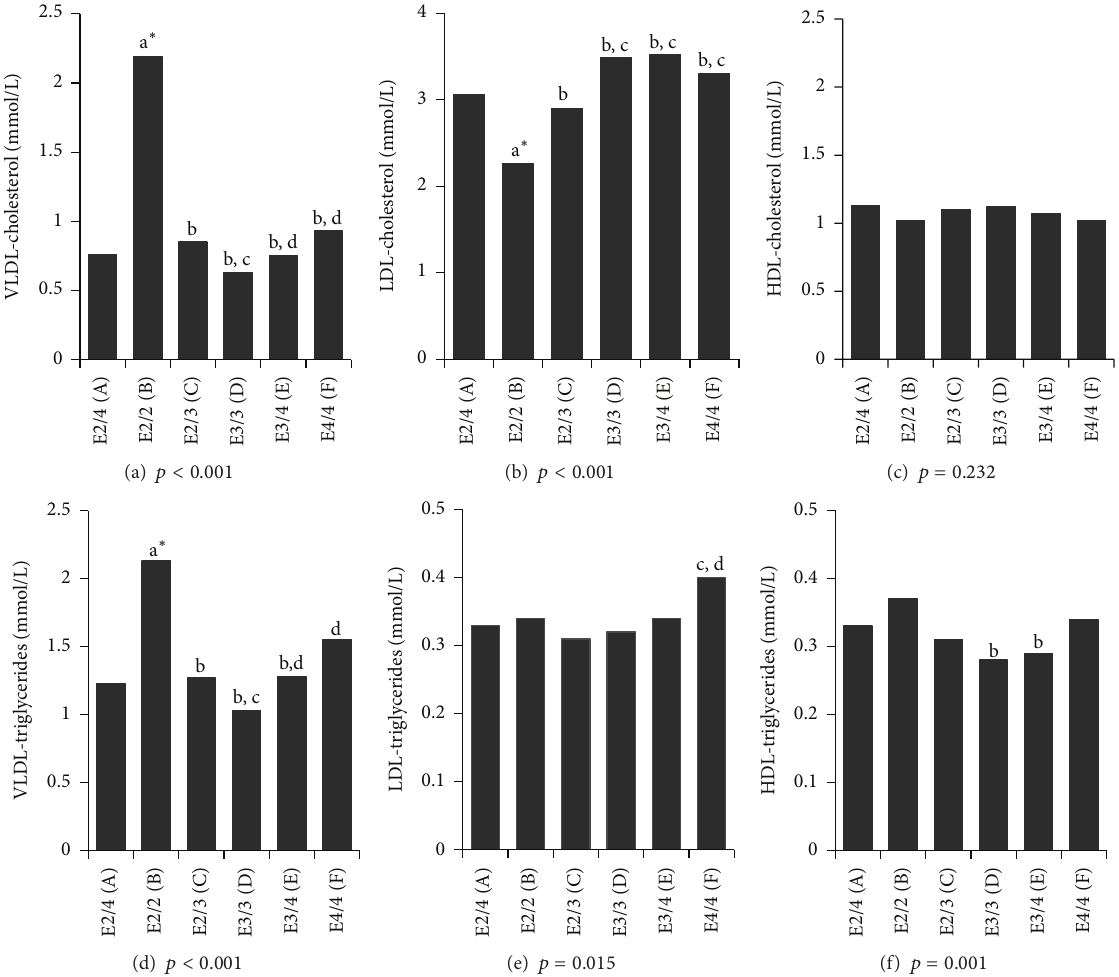
Figure 1: Lipid-lipoprotein profile determined after ultracentrifugation, according to the apolipoprotein E genotype, among a subsample of 1,531 subjects. Note: HDL, high-density lipoprotein; LDL, low-density lipoprotein; VLDL, very-low-density lipoprotein. Significantly ∗ E 2/4 , to b E 2/2 , to c E 2/3 , to d E 3/3 , and to E3/4 and when corrected for multiple testing. All 𝑝 values different (𝑝 < 0.05) as compared to a concerning VLDL-cholesterol, VLDL-triglycerides, and LDL-triglycerides concentrations were obtained after log 10 transformation of the data, and geometric means are shown. Men/women: E2/4 (36/36); E2/2 (37/37); E2/3 (197/199); E3/3 (324/356); E3/4 (129/143); E4/4